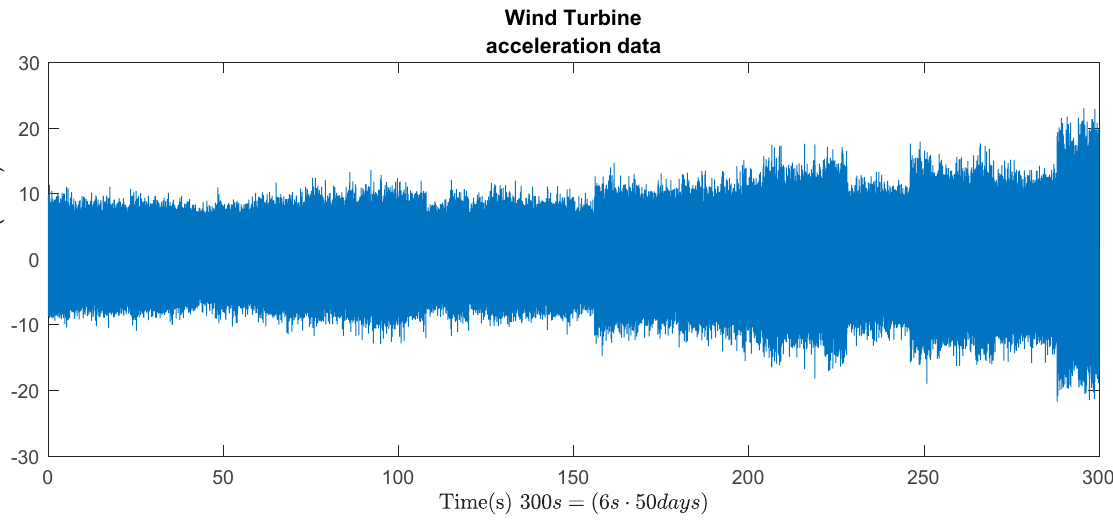
Figure 4. Run-to-failure vibration sensor measurements of WTHS.